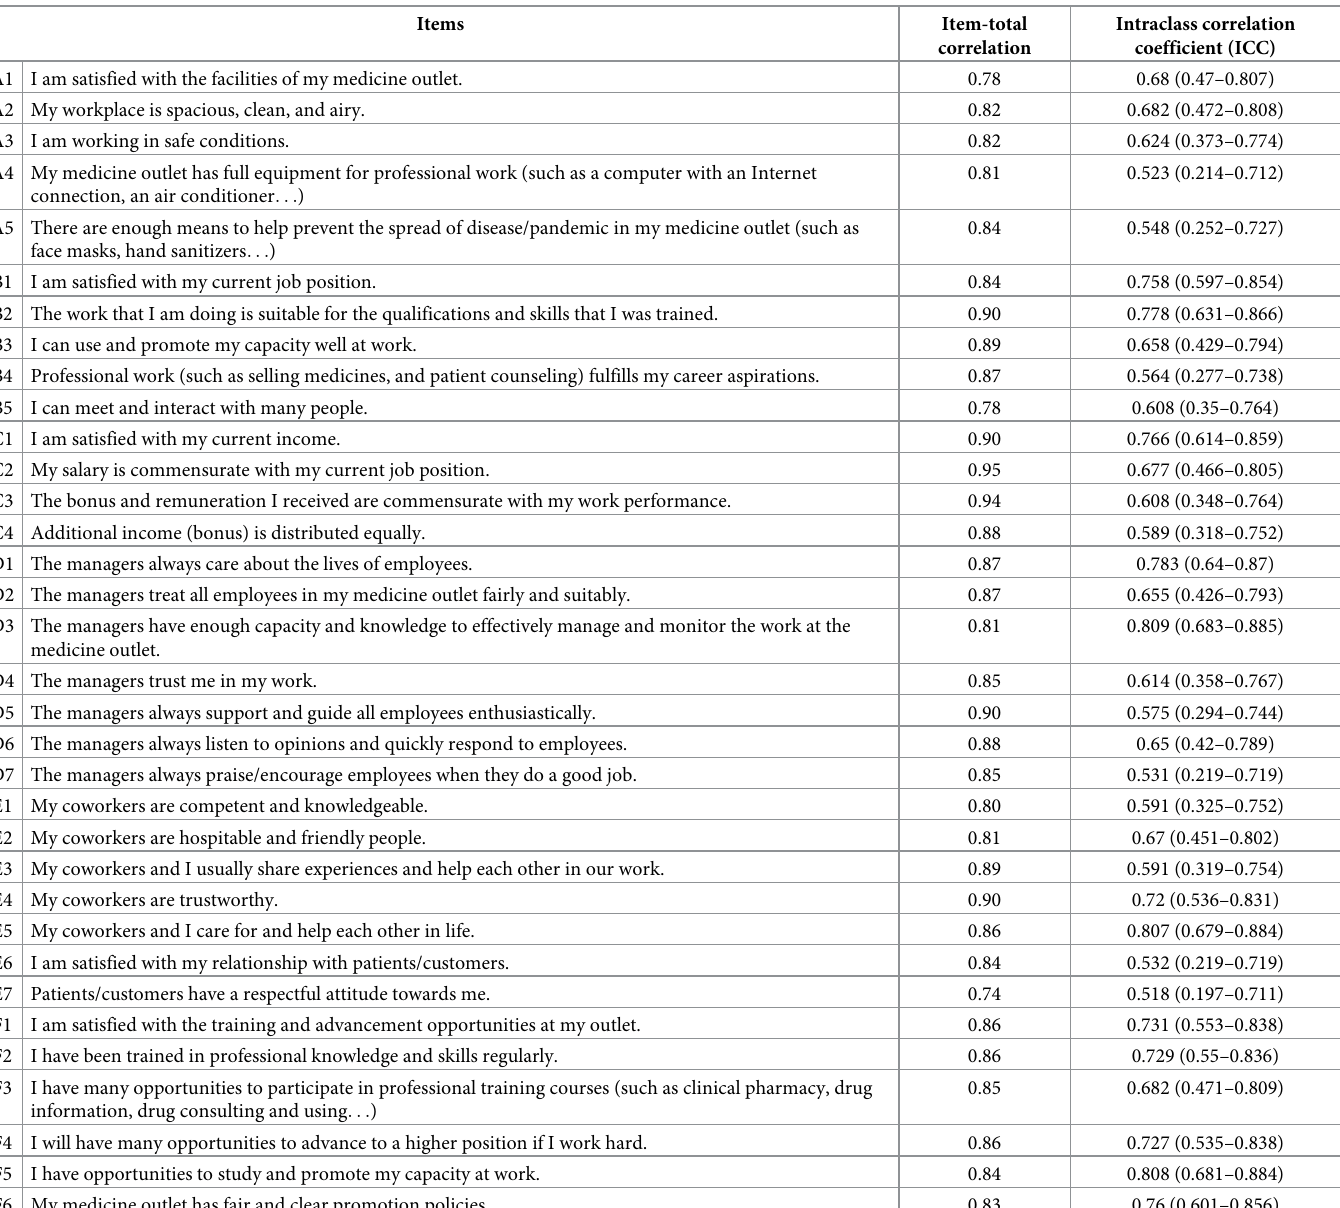
Table 1. Item names, item-total correlation, and two-week test-retest reliability of the VIJS. Items Item-total